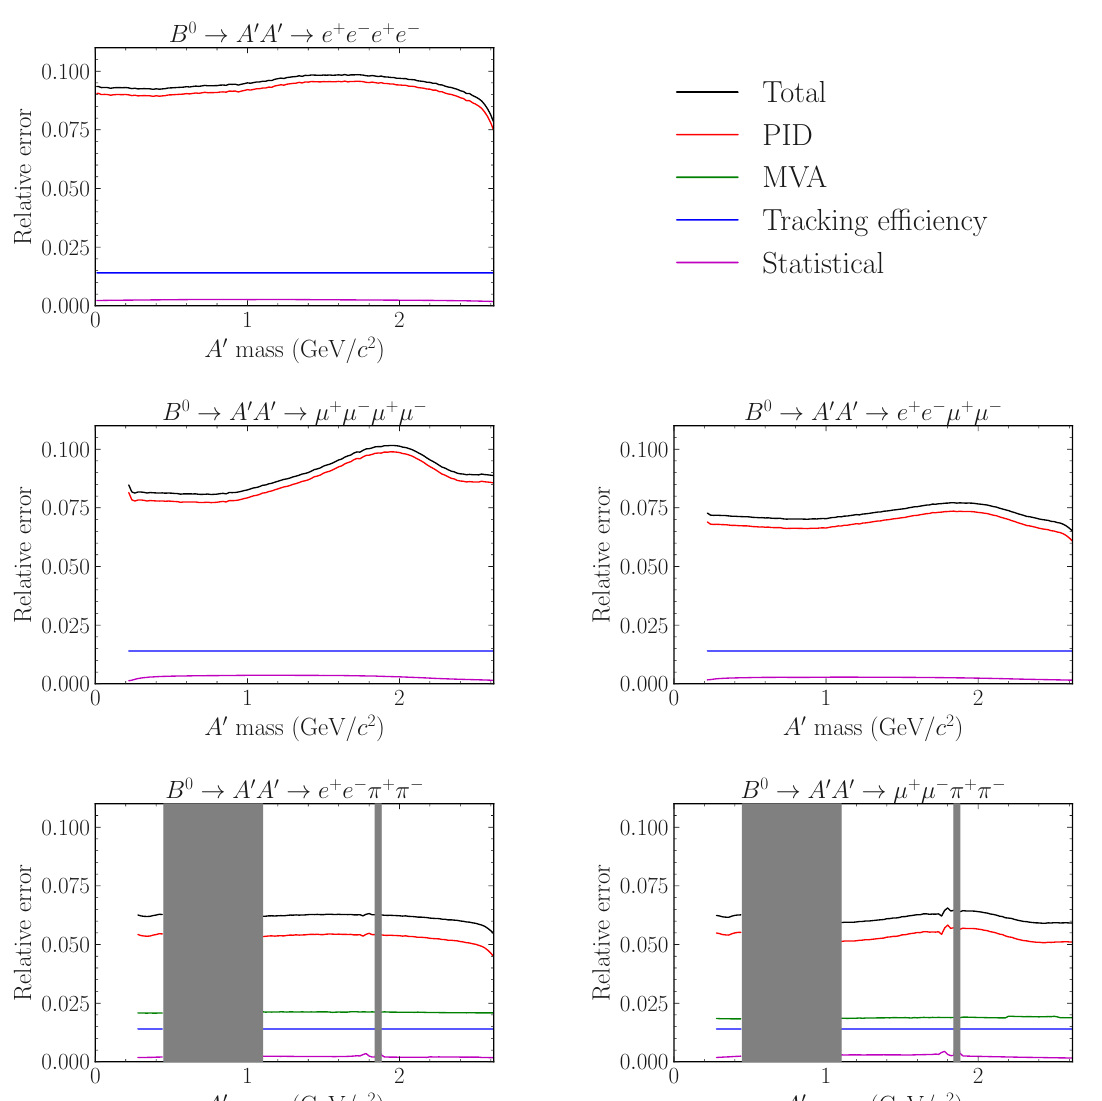
Figure 2 . Relative uncertainty of signal reconstruction efficiency for each A 0 mass and final